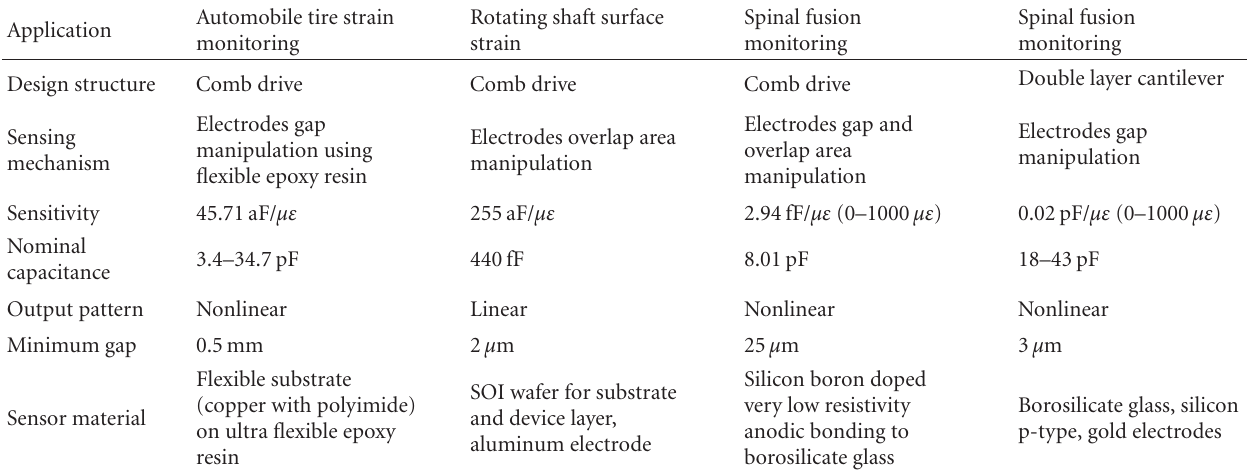
Table 1: Capacitive strain sensor comparison.